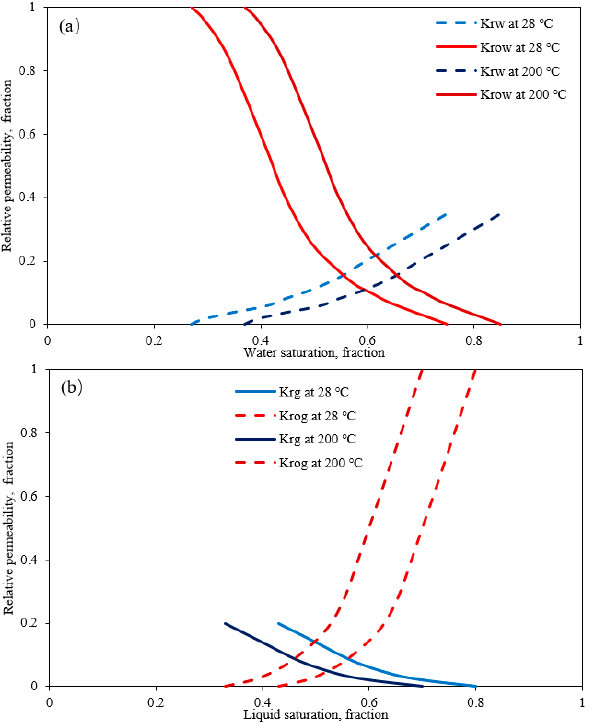
Figure 4. Relative permeability curves used in the simulation for ( a ) water–oil and ( b ) liquid–gas.